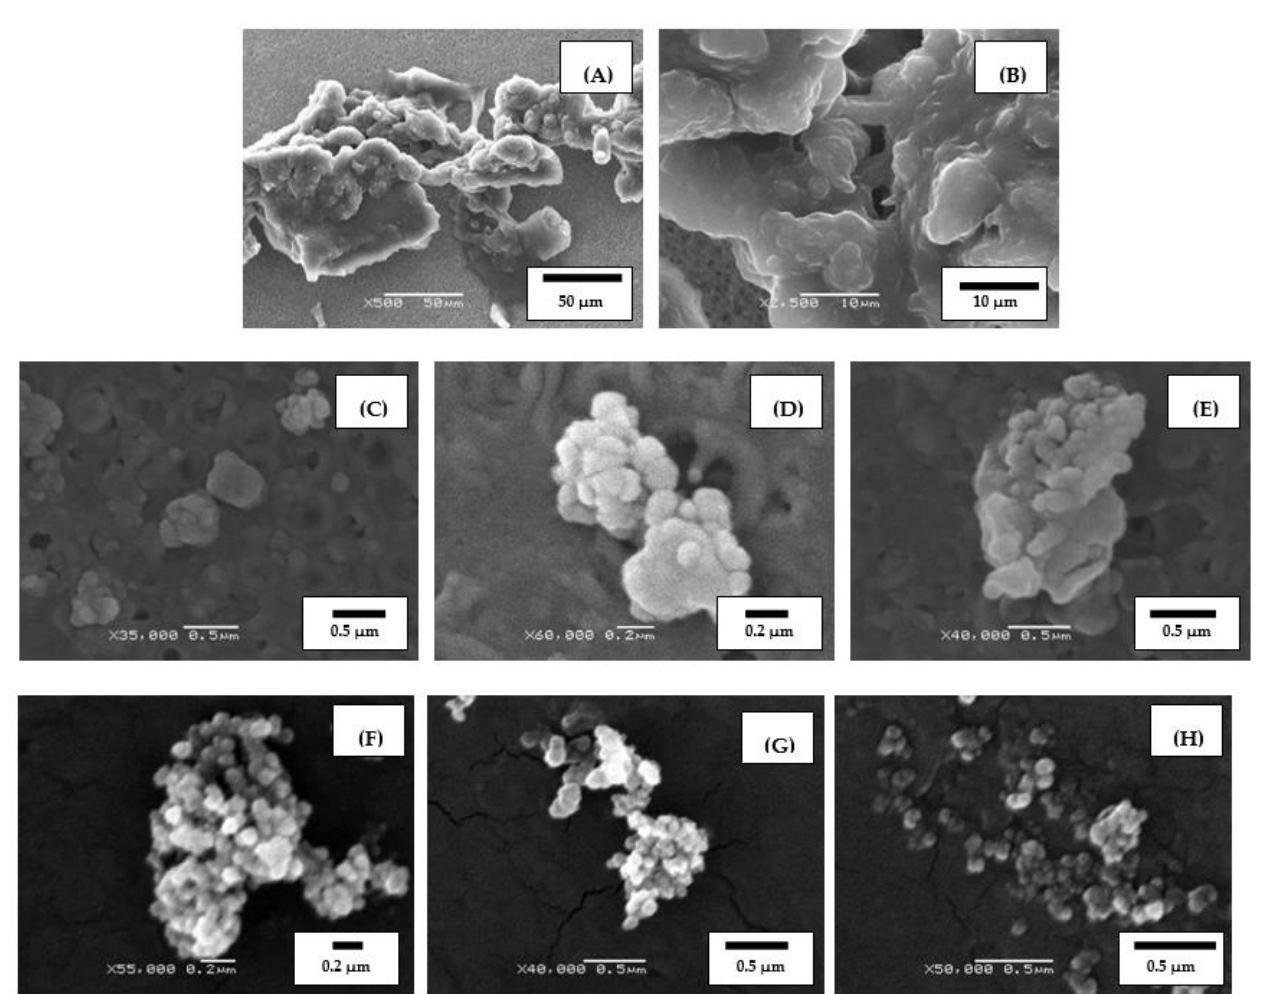
Figure 6. ( A , B ) SEM images of APDDR fragments with the formation of “strands” (after washing bitu- men from MB, prepared under conditions of 140 °C/1 – 40 min/135 rpm); ( C – E ) SEM images of PEM